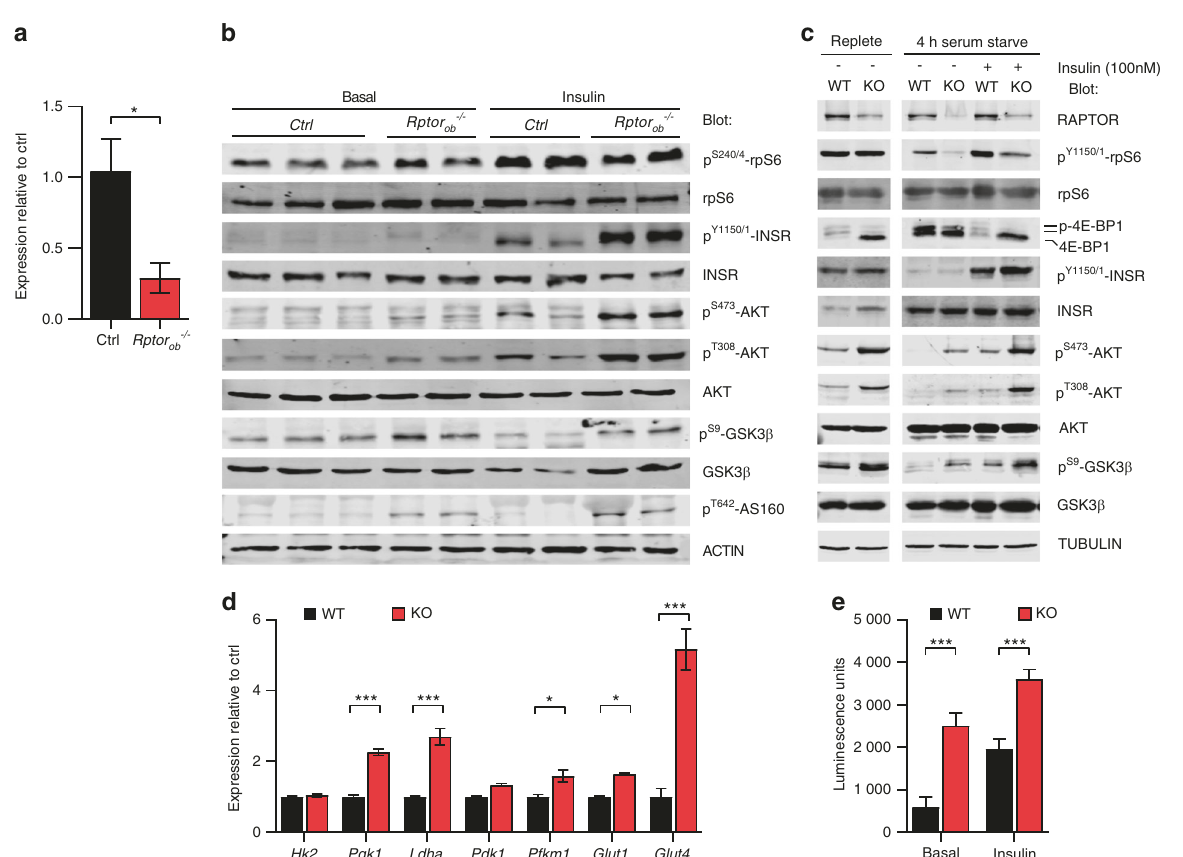
Fig. 8 In vivo and in vitro loss of OB-mTORC1 lead to potentiation of OB insulin signaling. a Gene expression of Rptor in the calvarial bone tissue, normalized to Actb ( n = 3 – 4/genotype). Data are expressed as mean ± SEM. * P < 0.05, unpaired Student ’ s t -test. b Western immunoblot analysis of indicated protein levels in calvarial bone tissue from 18-week-old HFD-fed mice collected after a 6 h fast under either basal (6-h fast + PBS; n = 2 – 3/genotype) or insulin-stimulated (6-h fast + insulin stimulation; n = 2/genotype) conditions. c Western immunoblot analysis of indicated protein levels in wildtype (WT) and Rptor knockout (KO) cultured primary osteoblasts collected under normal growth and a 4-h serum starved conditions before or after stimulation with 100 nmol·L − 1 insulin. d Gene expression analysis of glycolysis and glucose transporters in WT or Rptor KO OBs ( n = 3). e 2-Deoxy-D-glucose uptake (measured as units of luminescence) of WT or Rptor KO OBs under either basal or insulin-stimulated conditions. Data are expressed as mean ± SD. *** P < 0.001, unpaired Student ’ s t